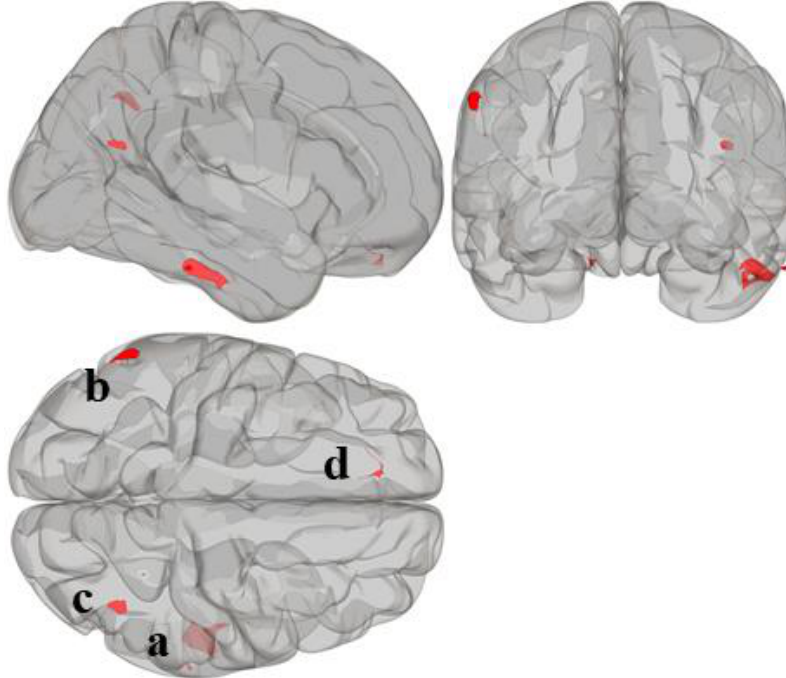
Figure 1. Whole-brain MVPA results indicating the regions that show connectivity patterns significantly associated with reading composite score. MVPA clusters are referred to as a, b, c, and d.